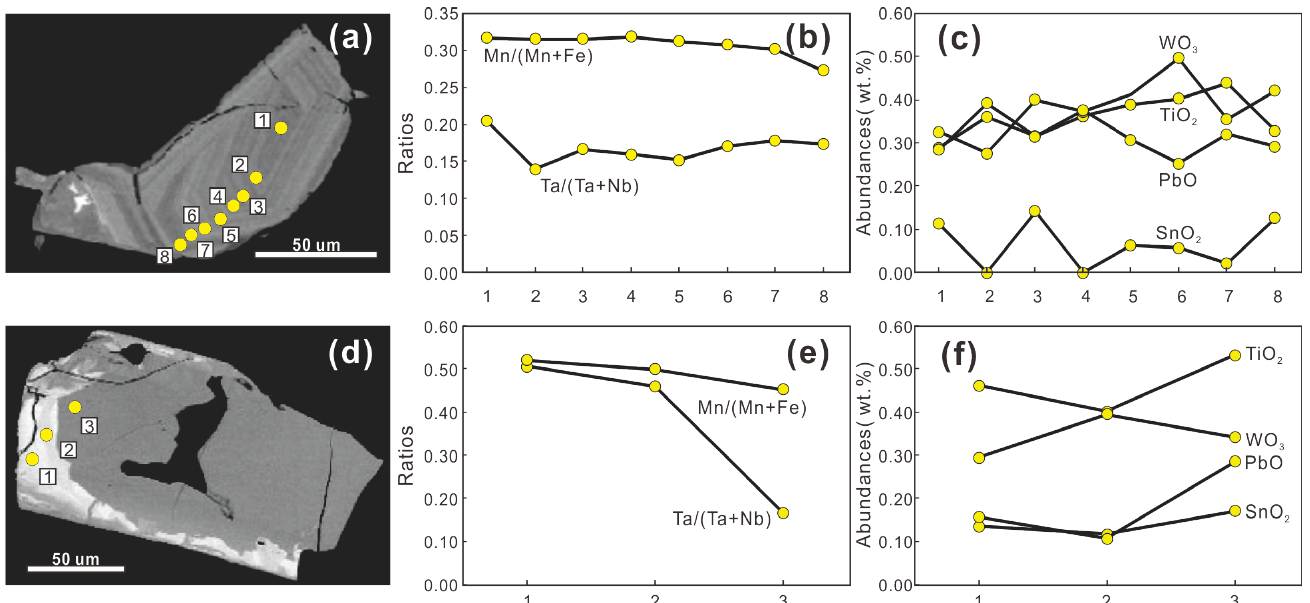
Figure 6. Electron probe microanalysis profiles showing the chemical variations of typical CGMs-1 ( a – c ) and CGMs-3 ( d – f ) from core to rim. Analyzed numbers and sites are marked as yellow circles (not to scale) in the backscattered electron images of ( a ) and ( d ), and the corresponding contents and ratios of elements are shown in the form of change curve ( b,c , e , f ).